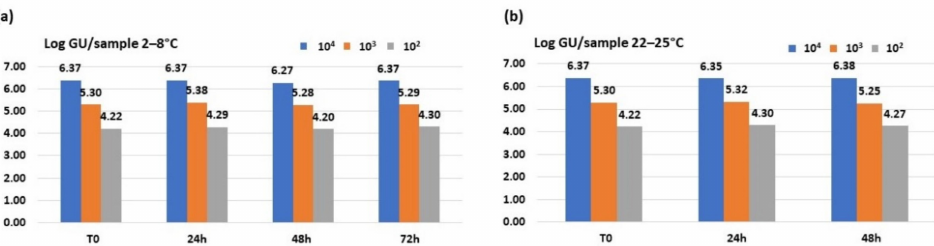
Figure 2. Genomic units/sample detected from 10 4 , 10 3 and 10 2 CFU/mL dilutions stored at ( a ) 2–8 ◦ C and ( b ) 20–25 ◦ C using iQ-Check ® Quanti Legionella spp. Real-Time assay.